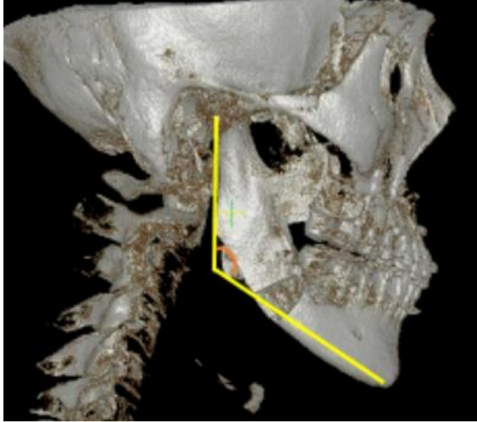
Figure 1. Mandibular angle: